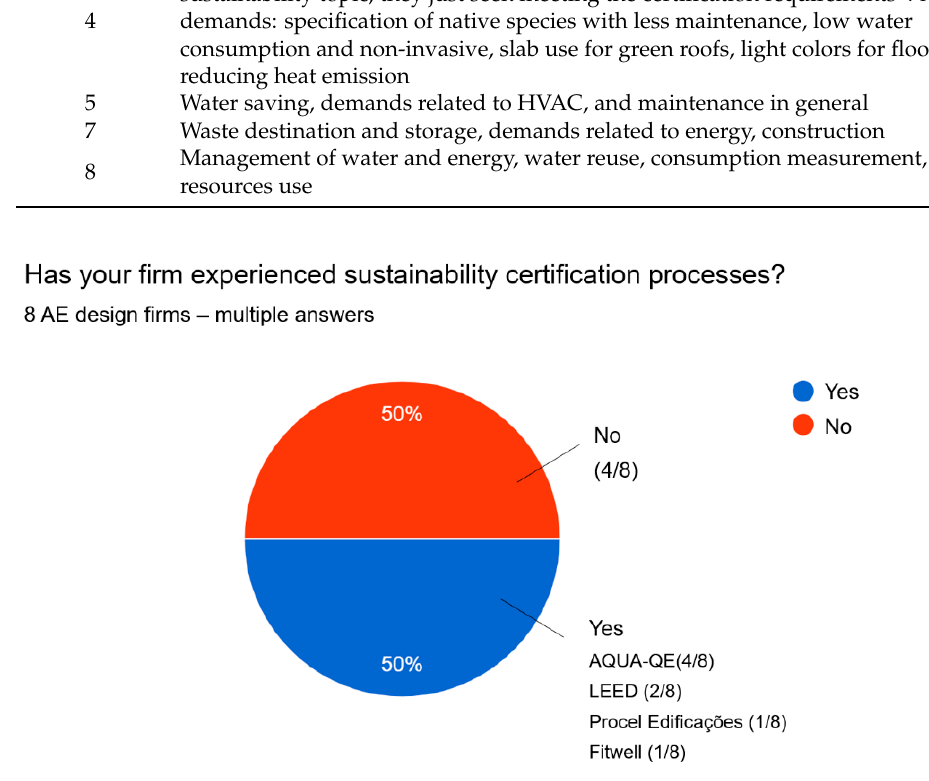
Figure 1. Design firms’ experiences with sustainability certification processes.